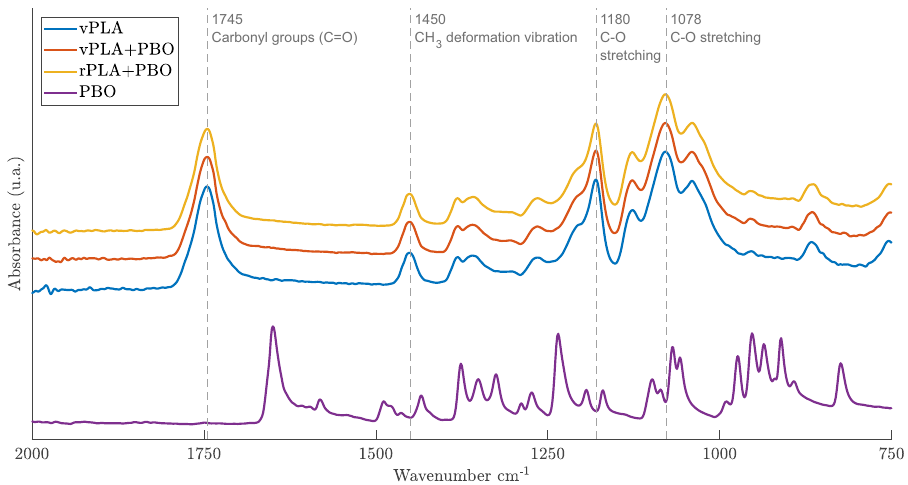
Figure 9. FTIR spectra for virgin PLA (vPLA),chain extender (PBO), virgin PLA mixed in the presence of PBO (vPLA+PBO), and recycled PLA mixed in the presence of PBO